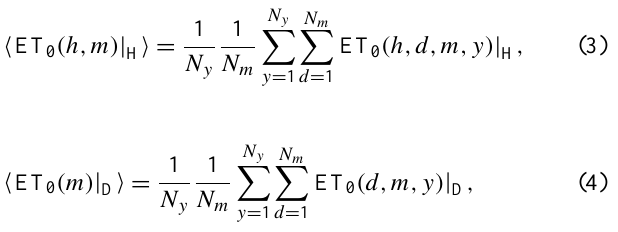
Fig. 6. Comparison between the empirical cumulative density functions (ECDFs) of the small-scale observed precipitation fields and the 90% confidence intervals derived from an ensemble of 100 synthetic fields generated with the downscaling tool. The small-scale precipitation intensities were standardized and indicated as i ∗ (see text for details). Panels (a) – (d) and (e) – (h) show results for the applications in the time and space–time domains, respectively, while panels (i) – (l) report results for the entire disaggregation procedure.